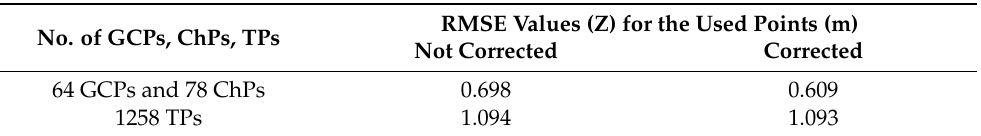
Table 4. Vertical evaluation of the 3D reconstructed point clouds for the two scenarios: uncorrected GNSS-RTK measurements and corrected GNSS-RTK measurements with the local quasigeoid surface and using the LR ALS-DTM in the dense image matching process.